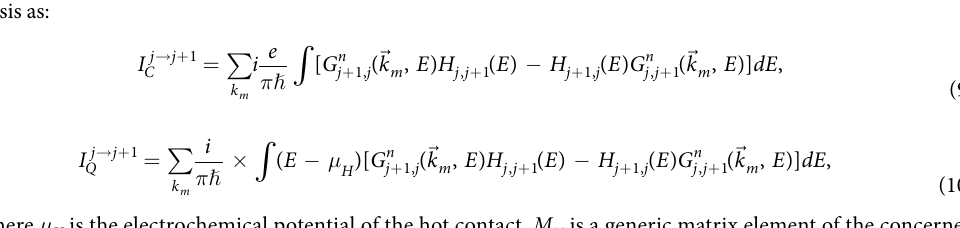
where μ H is the electrochemical potential of the hot contact, M i , j is a generic matrix element of the concerned operator between two lattice points i and j . In the tight-binding scheme used here, we only consider the next nearest neighbor such that j = i ± 1. A list of parameters used for the simulation of the NEGF equations are given in Table 1.